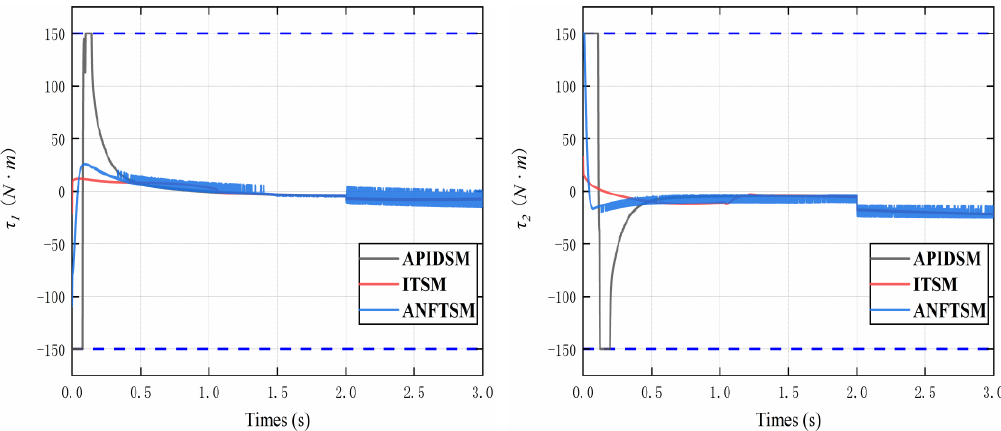
Figure 12. Comparison of position tracking error results between controllers of Joint 1 and Joint 2.